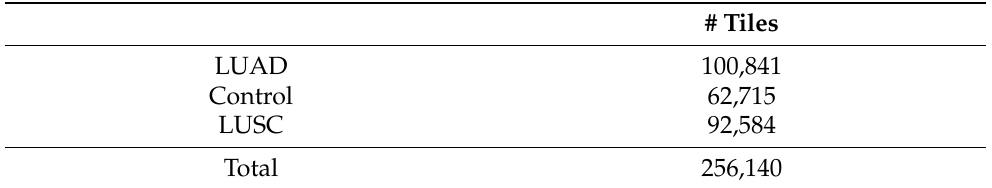
Table 3. Number of tiles obtained from the WSI per